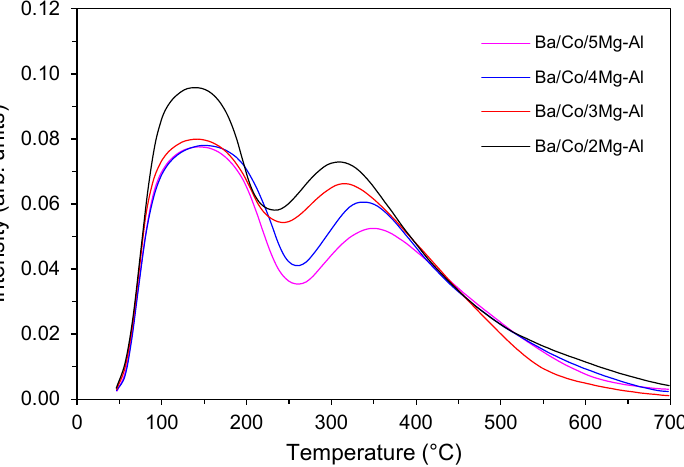
Figure 8. CO 2 -TPD profiles of the Ba/Co/Mg-Al catalysts supported on mixed oxides with various Mg/Al molar ratios.